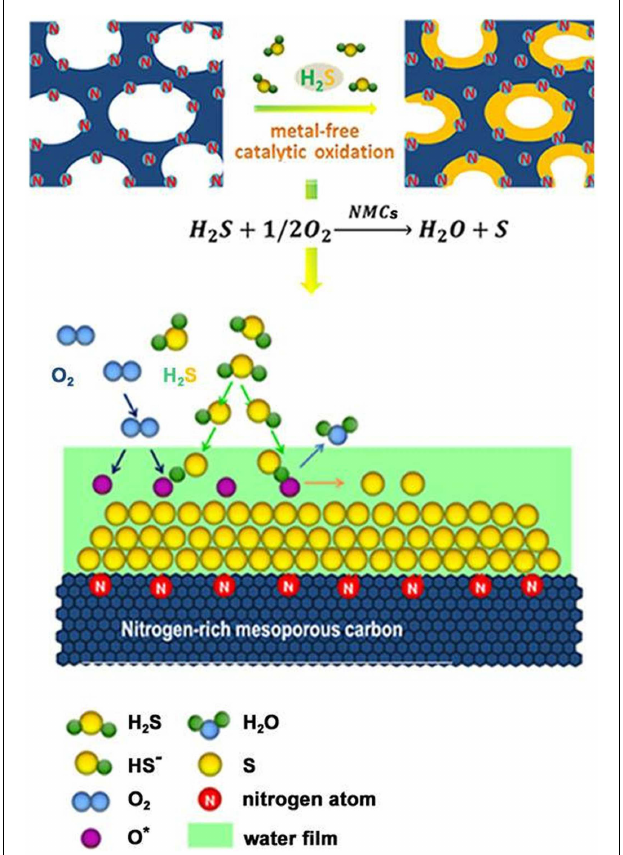
FIGURE 2 | Schematic diagram of the formation of elemental sulfur on the surface of nitrogen-enriched mesoporous carbon (Sun et al., 2013b)